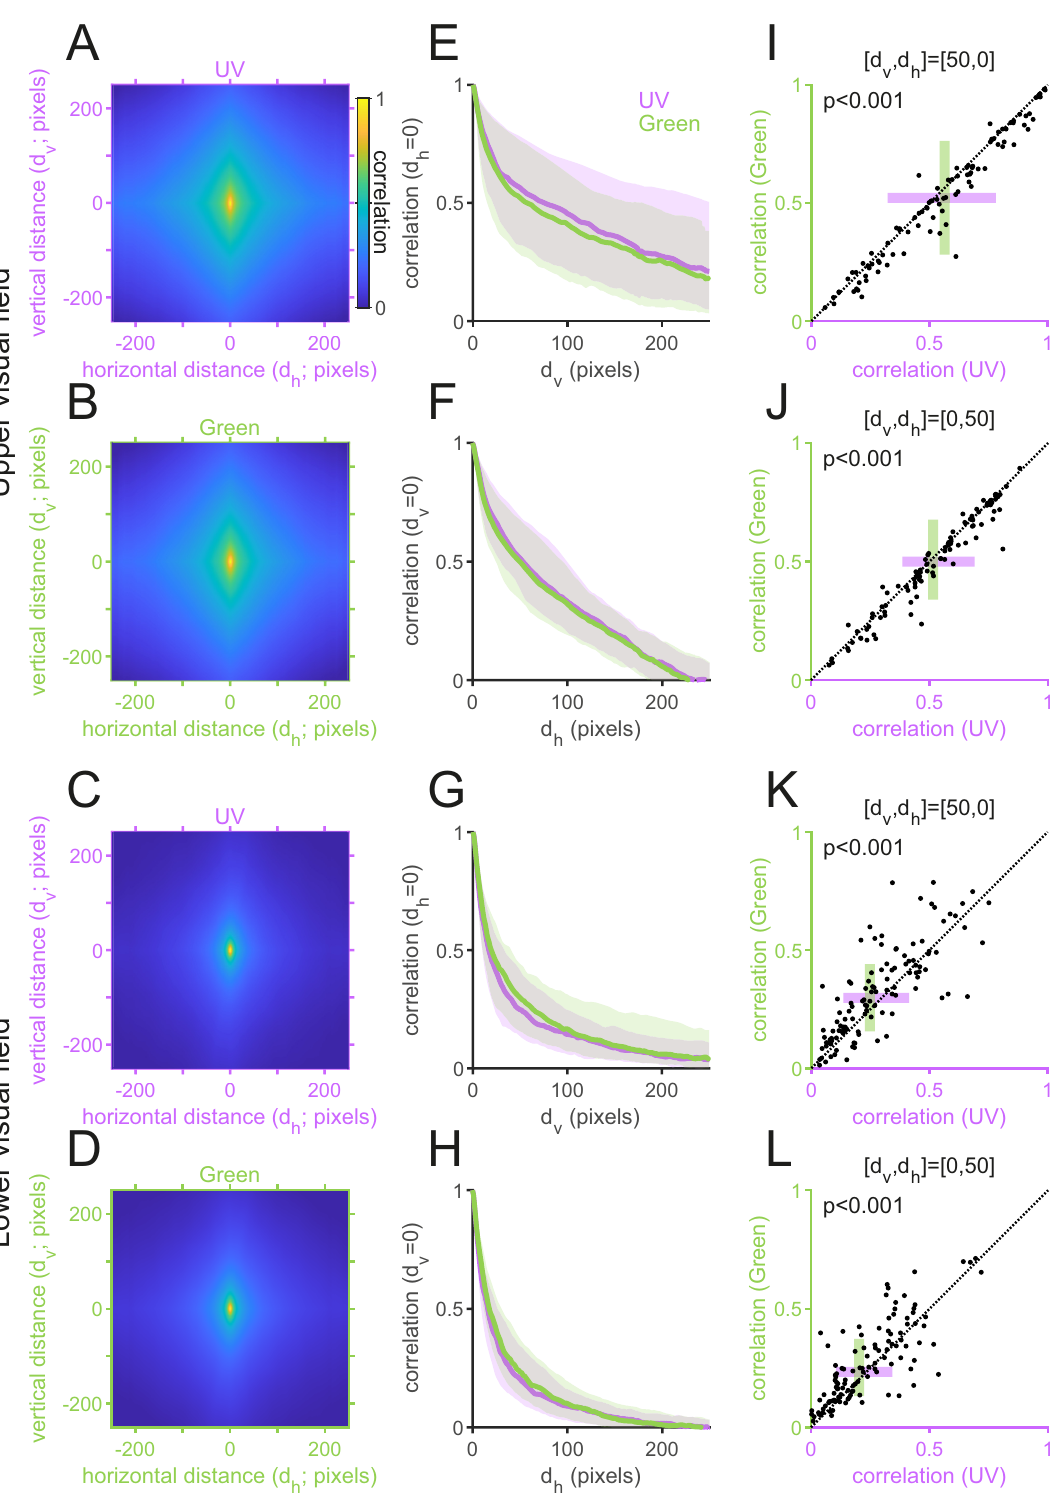
Fig 6. Spatial autocorrelation of the “mouse-view” natural images. (A–D) The average spatial autocorrelation of the upper (A,B) and lower (C,D) visual field images for the UV (A,C) and Green (B,D) channels, respectively. (E–H) The spatial autocorrelation in the vertical (E,G) and horizontal (F,H) directions (median and interquartile range). The UV channel has a higher and wider spatial correlation for the upper